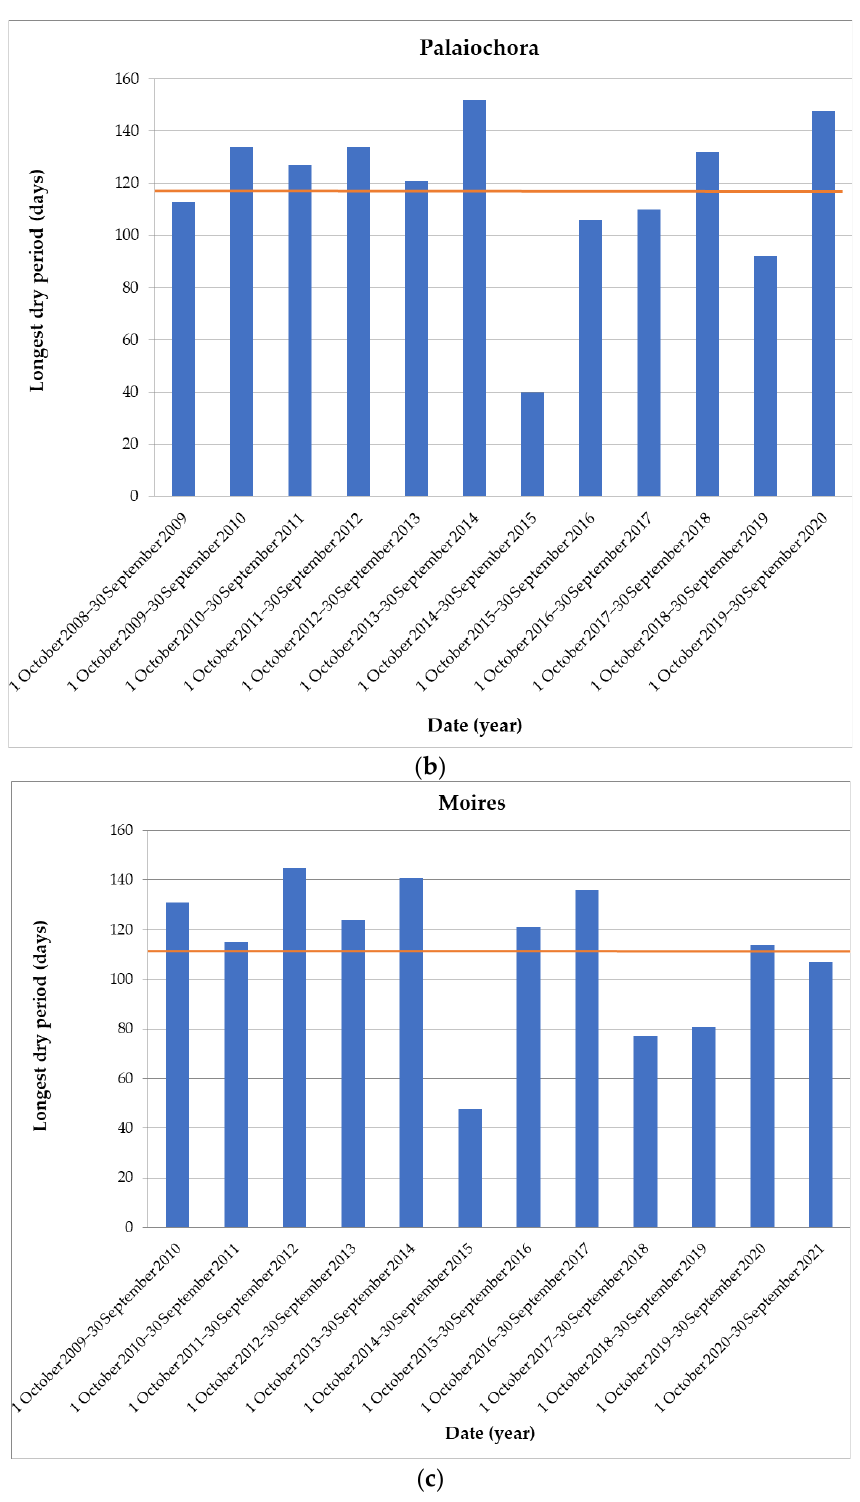
Figure 4. Distribution of the longest annual dry periods in the 12-year period studied for the three rainfall stations, Crete Island (Greece): ( a ) Vrysses, ( b ) Palaiochora and ( c ) Moires. The mean longest annual dry period value for each station is depicted by the horizontal line.